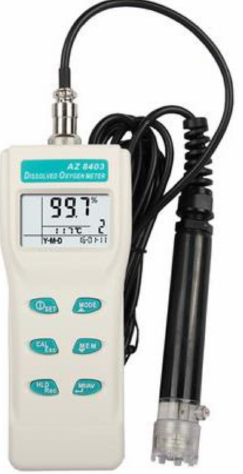
Figure 3. AZ8403 portable DO meter.